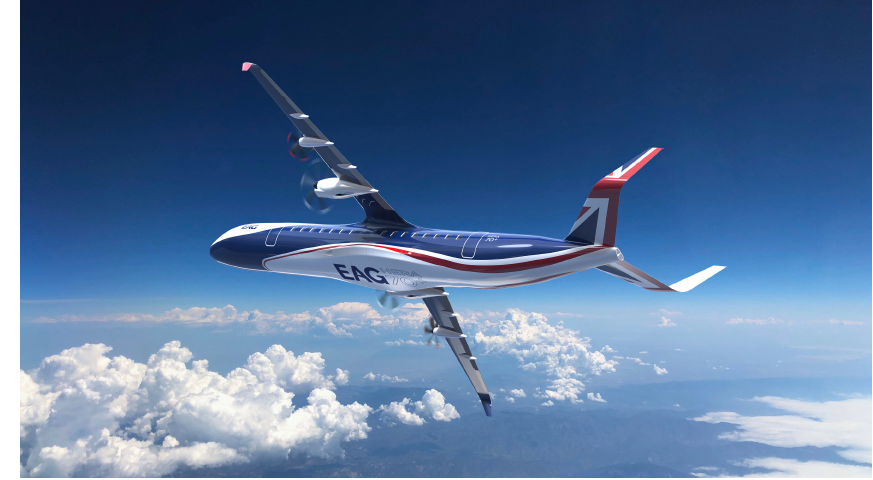
Figure 10. EAG Hybrid Electric Regional Aircraft (HERA) (Photo:PRNewsfoto/EAG).